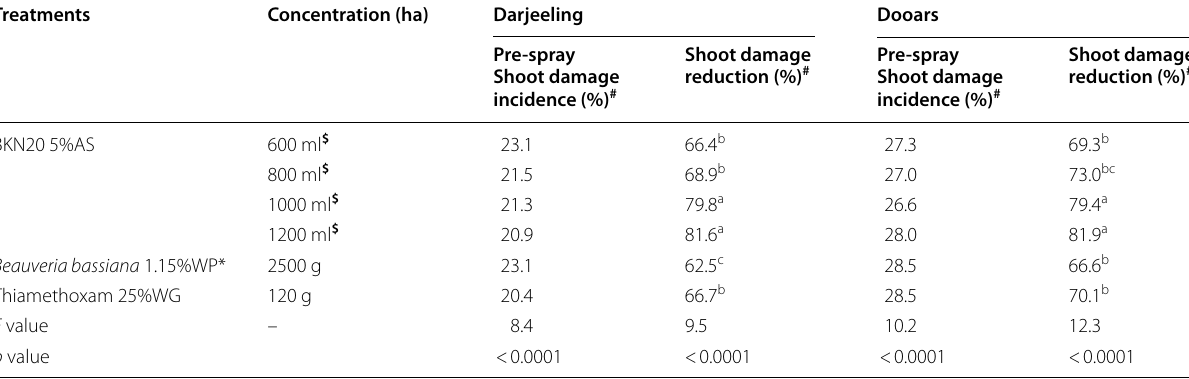
# Pre-spray shoot damage incidence (%) and shoot damage reduction (%) values for each location are the mean of two consecutive seasons $ Containing 2 10 7 conidia/ml, Pre-spray shoot damage incidence (%) are the mean of three replications SE of leaf plucking before treatments and shoot damage × ± reduction (%) are the mean of three replications SE obtained from four rounds of leaf plucking after treatments at weekly interval for each season. Values in the ± same column with different superscript are significantly different with each other at p < 0.05 by Tukey’s post-hoc Honestly Significant Difference (HSD) test *Market product